Question: What form of chart is displayed?
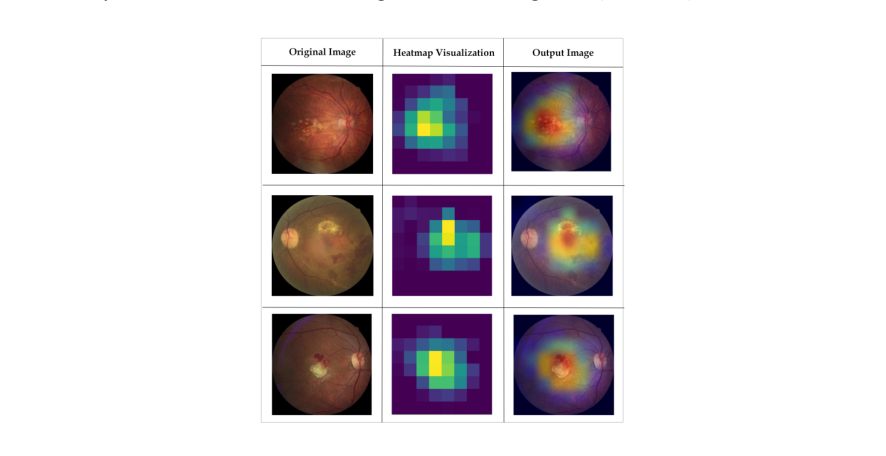
Answer: heatmap